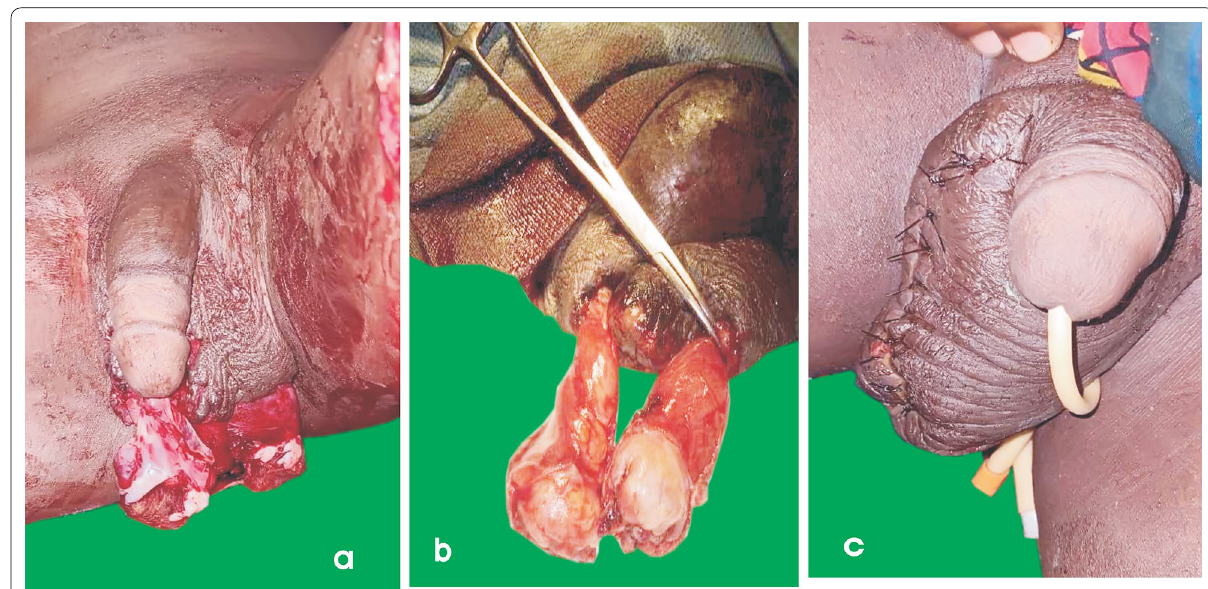
Fig. 2 a Grade 4 AAST Testicular injuries with extruded seminiferous tubules. b Repaired testes after meticulous debridement c Post‑operative repair